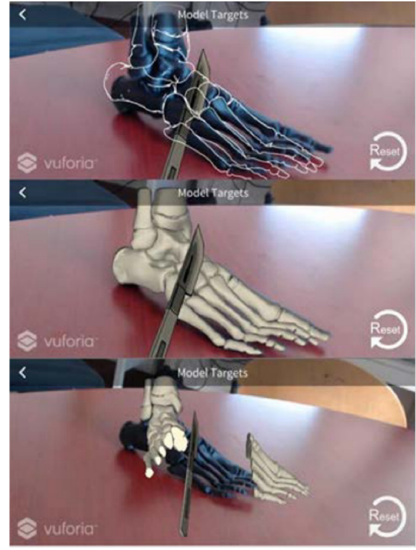
Figure 7. Example of cutting 3D model